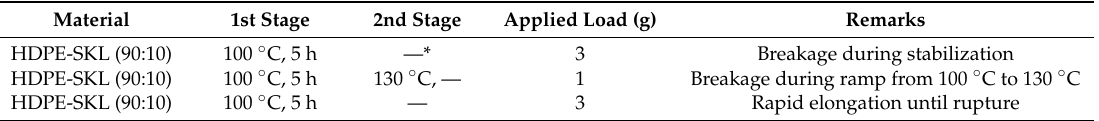
Table 5. Thermal oxidative stabilization experiments (stabilization apparatus).